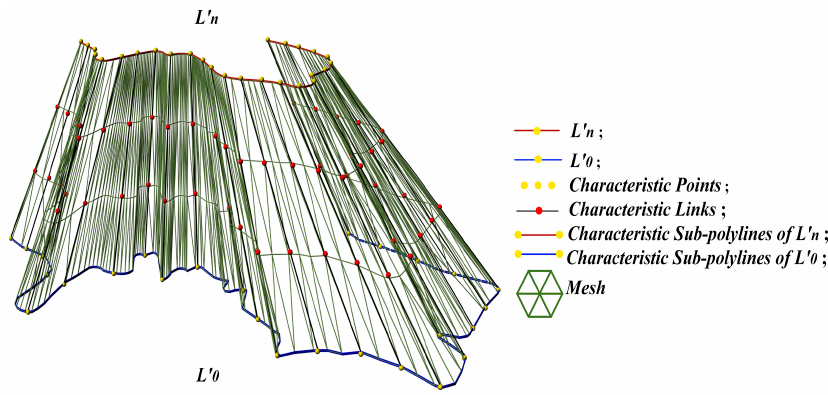
Figure 5. CCS-mesh covered by triangular faces.